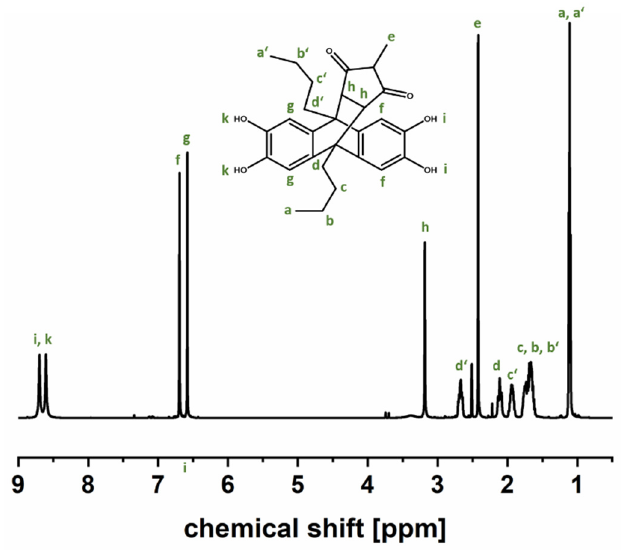
Figure 2. 1 H NMR spectrum of the methyl-comonomer.